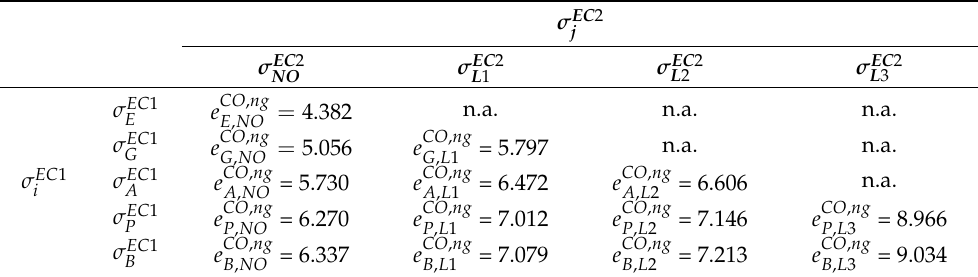
Table 6. Computational results of the virtual CO emission in kg within one cycle.